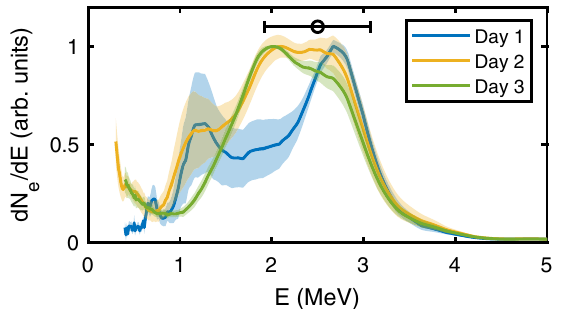
FIG. 6. Electron spectra obtained on three different days with the same one-sided shock nozzle. Spectra are the results of averaging over 2000 shots for day 1 and day 2, and 5000 shots for day 3. Day 1 and day 2 are 7 days apart, day 2 and day 3 are 6 days